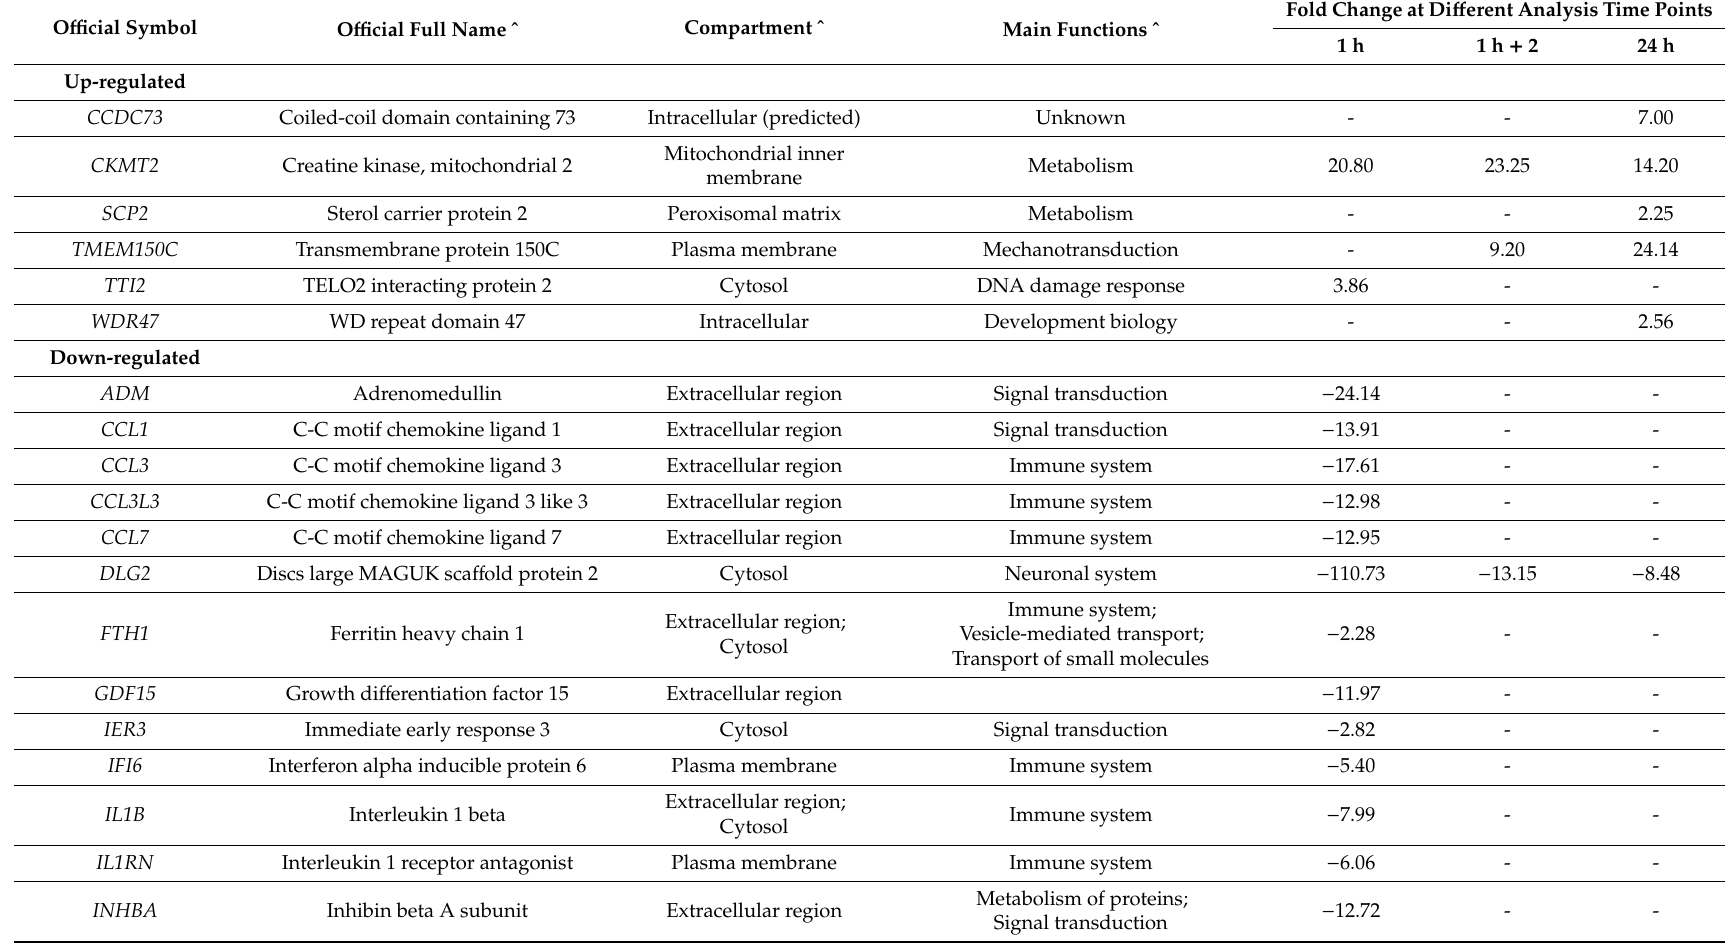
Table 2. Di ff erentially expressed genes in U937 cells. Whenever significant, fold change values are shown. Only genes detected as up-or down-regulated in respect of parallel control samples are